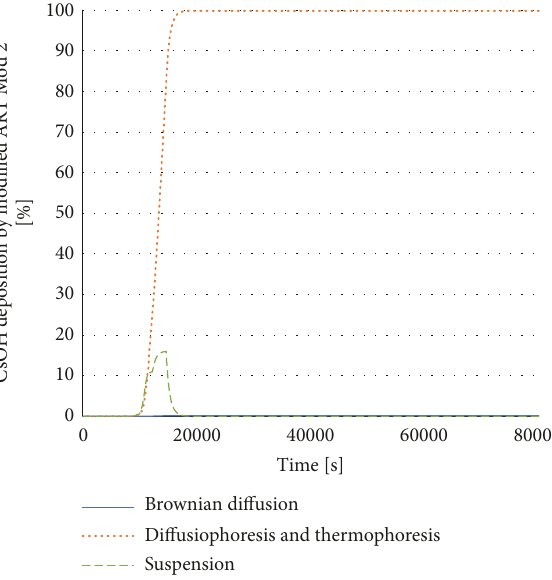
Figure 15: CsOH deposition in dry condenser volume calculated by modified ART Mod 2.